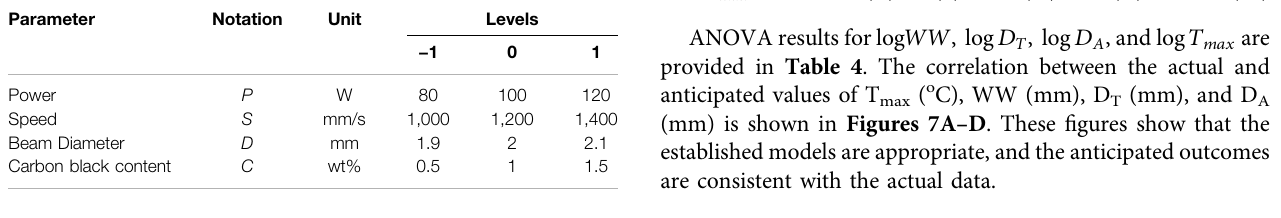
TABLE 2 | Process Control parameters and their levels. Parameter Notation